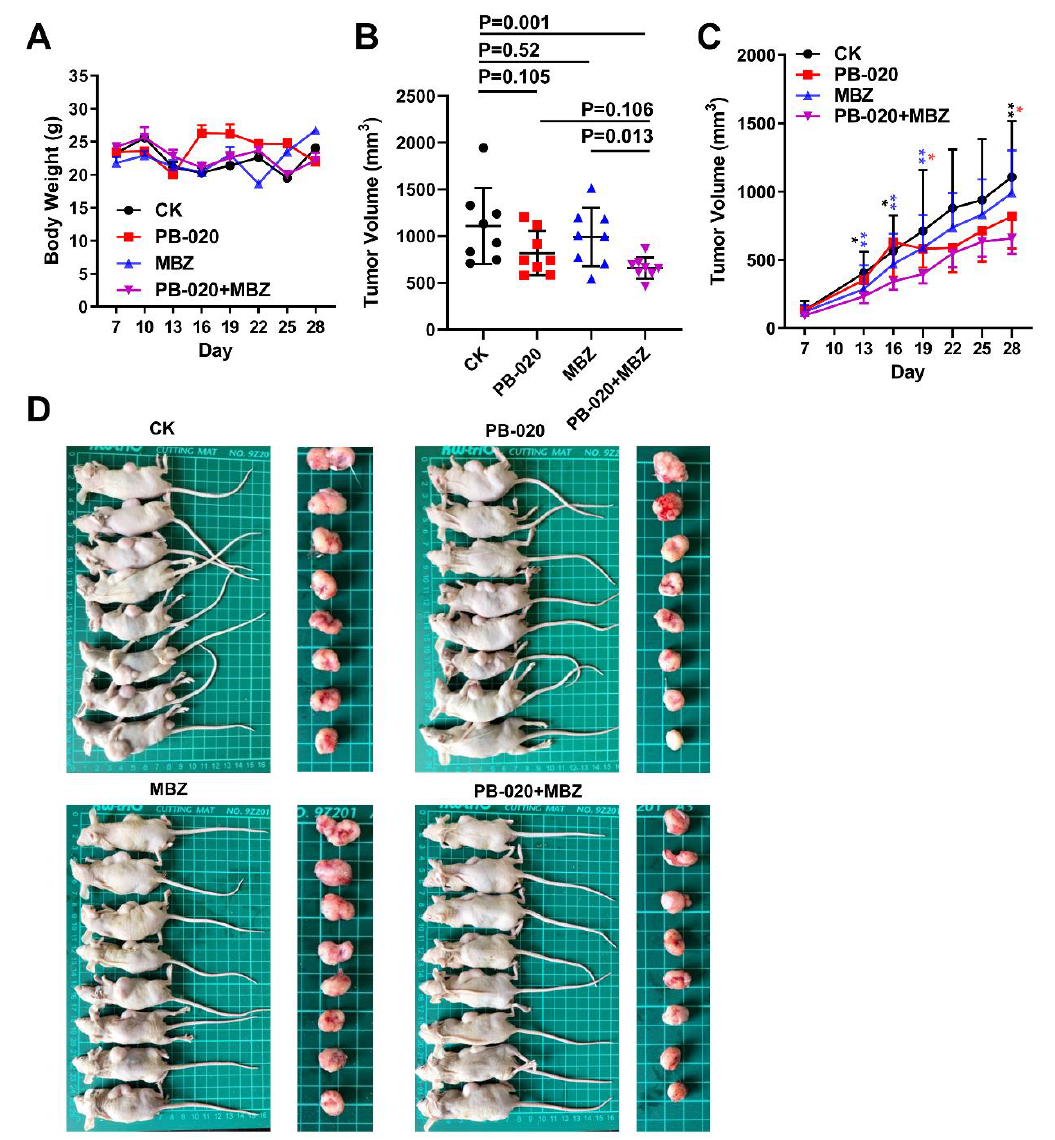
Figure 3. Orally administered PB-020 in combination with MBZ inhibited propagation of HT-29 cell xenografts in vivo. ( A ) Vehicle (CK), PB-020, MBZ or PB-020/MBZ combination orally administered to BALB/c nude mice, as detailed in “Materials and methods”. The effect of compound adminis- tration on body weight changes in xenograft mice is presented. ( B ) Tumor volumes at day 28 were plotted. The statistical significance of data was evaluated using the two-tailed unpaired Student’s test. ( C ) Tumor volumes as a function of time (days) were plotted. The statistical significance of data was evaluated using the two-tailed unpaired Student’s test, and differences between PB-020 + MBZ vs. CK, PB-020 + MBZ vs. PB-020 and PB-020 + MBZ vs. MBZ are shown as black, red and blue stars. Significances were determined as p < 0.05 (*), p < 0.01 (**). ( D ) Sacrificed mice ( left ) and their bearing tumors ( right ) are